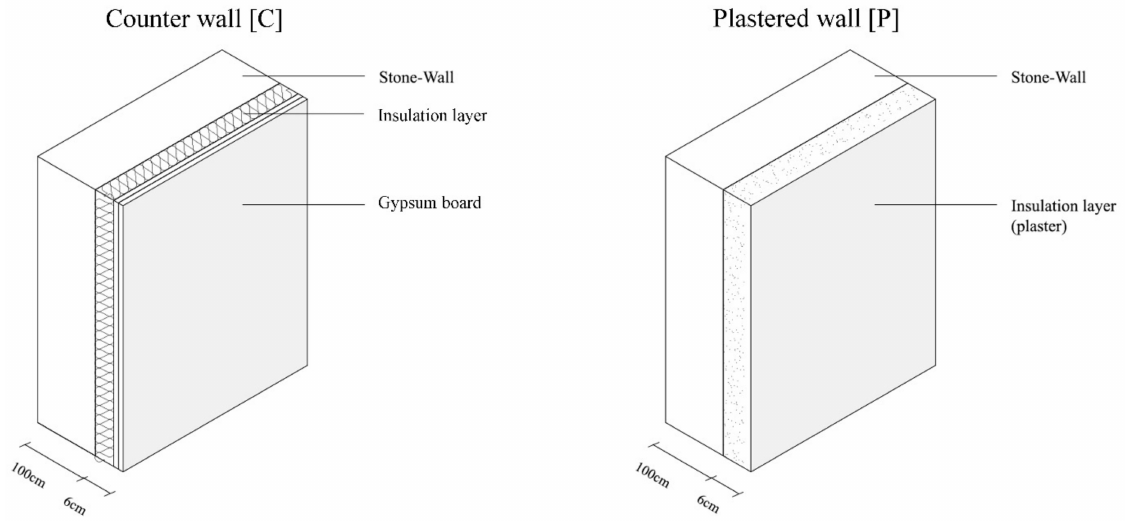
Figure 2. Schematic representation of the two considered configurations (not in